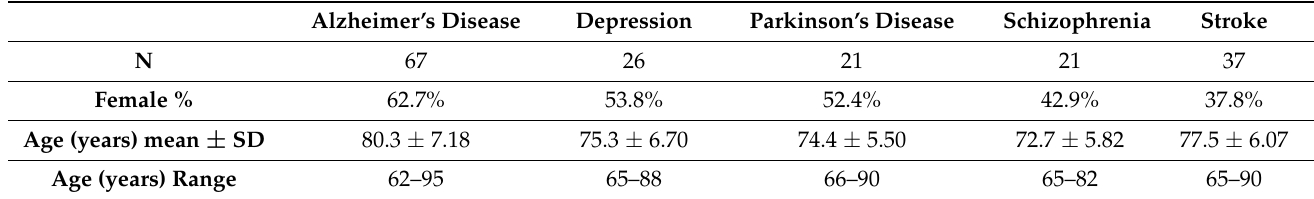
Table 2. Demographic characteristics of patients.